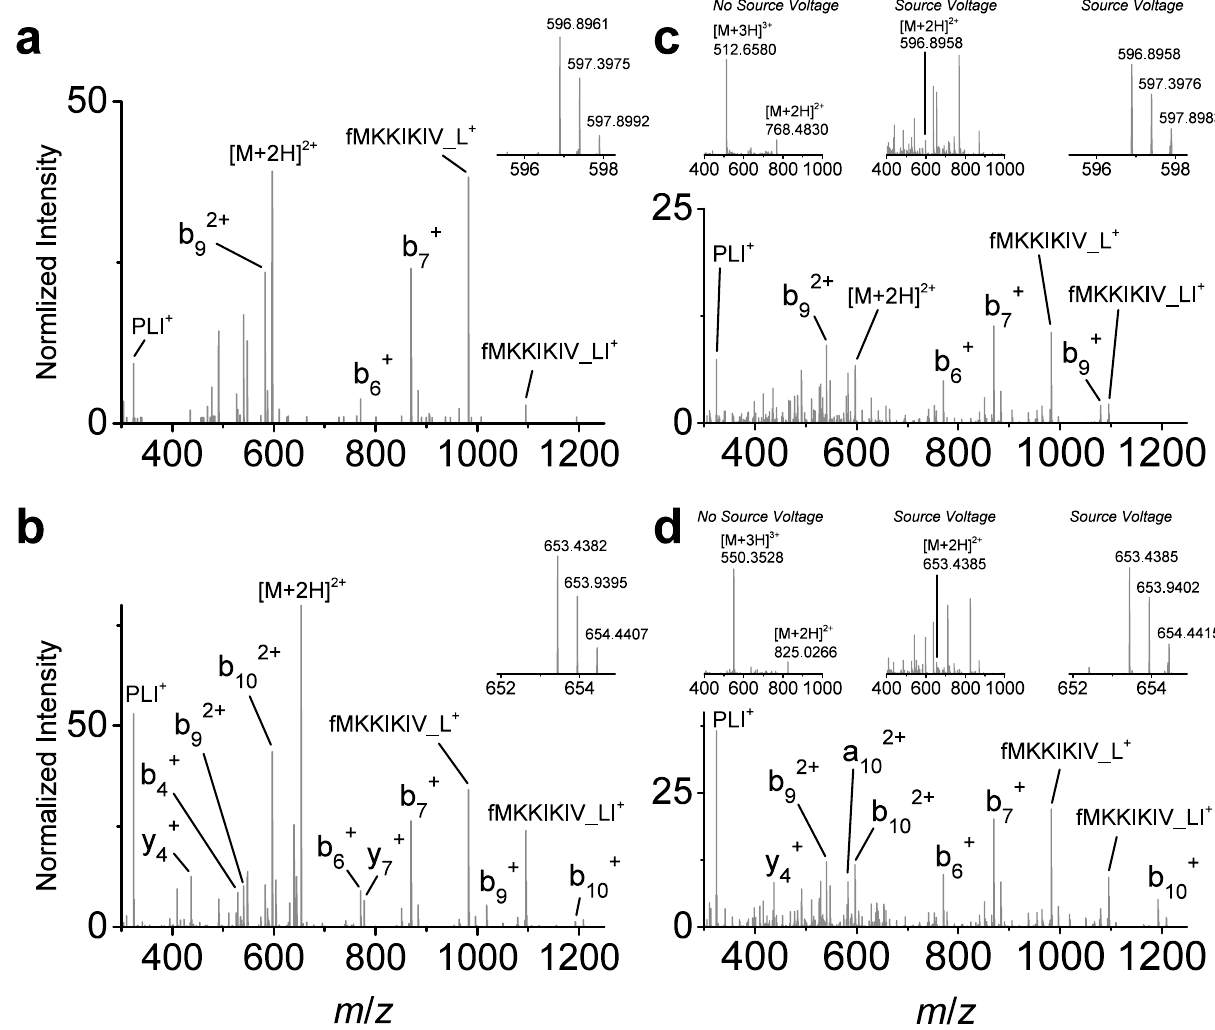
Figure 2. PBP2a mecA protein detection using in-source generated peptide-like fragments and MS/MS fragmentation. (a , b ) Source-induced dissociated N-terminal peptide-like fragments from PBP2a mecA (ATCC MRSA isolate BAA-44) at precursor m / z 596.8961 (a) and m / z 653.4382 ( b ) for selected ion monitoring (insets) and associated representative targeted MS/MS spectra (n ≥ 100). ( c ) Synthetic peptide confirmation of source- induced dissociated peptide-like precursor m / z 596.8961 and associated MS/MS spectrum (inset spectrum series displays peptide spectrum without in-source energy, with in-source dissociation, and magnified spectrum of target precursor following in-source dissociation). ( d ) Synthetic peptide confirmation of source-induced dissociated peptide-like precursor m / z 653.4382 and associated MS/MS spectrum (inset spectrum series displays peptide spectrum without in-source energy, with in-source dissociation, and magnified spectrum of target precursor following in-source dissociation). Data collection for synthetic peptides was repeated multiple times on different MS instruments (n =